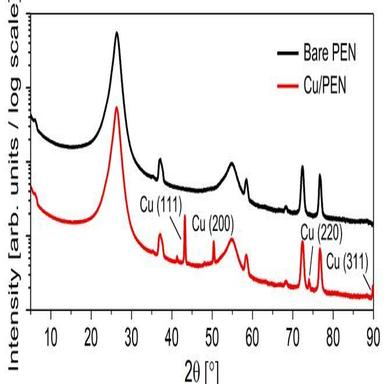
XRD characterization of bare PEN and Cu-coated PEN (tf=240 nm) with 5◦<2θ<90◦. The XRD pattern indicates that the evaporated Cu film is polycrystalline.